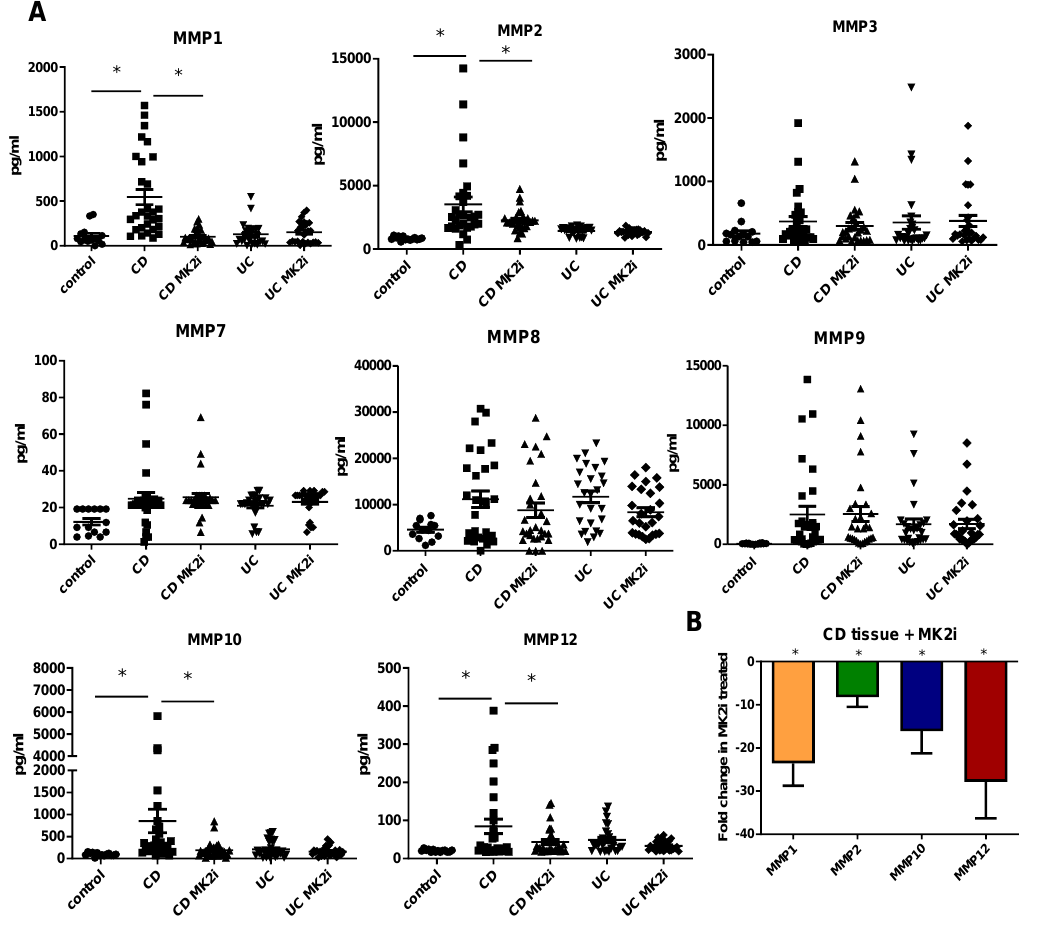
Figure 3. MMP production is increased in IBD tissues, but some are decreased by MK2 inhibition where ( A ) multiplex arrays of tissue supernatants indicate the MMP1, MMP2, MMP10, and MMP12 are produced by CD tissues and significantly decreased when tissues are treated with MK2 inhibitors and ( B ) gene expression of these MMP2 is also decreased by tissues incubated with MK2 inhibitors. N = 23 for control, 29 for CD, and 27 for UC, and 8 for gene expression * p < 0.05.